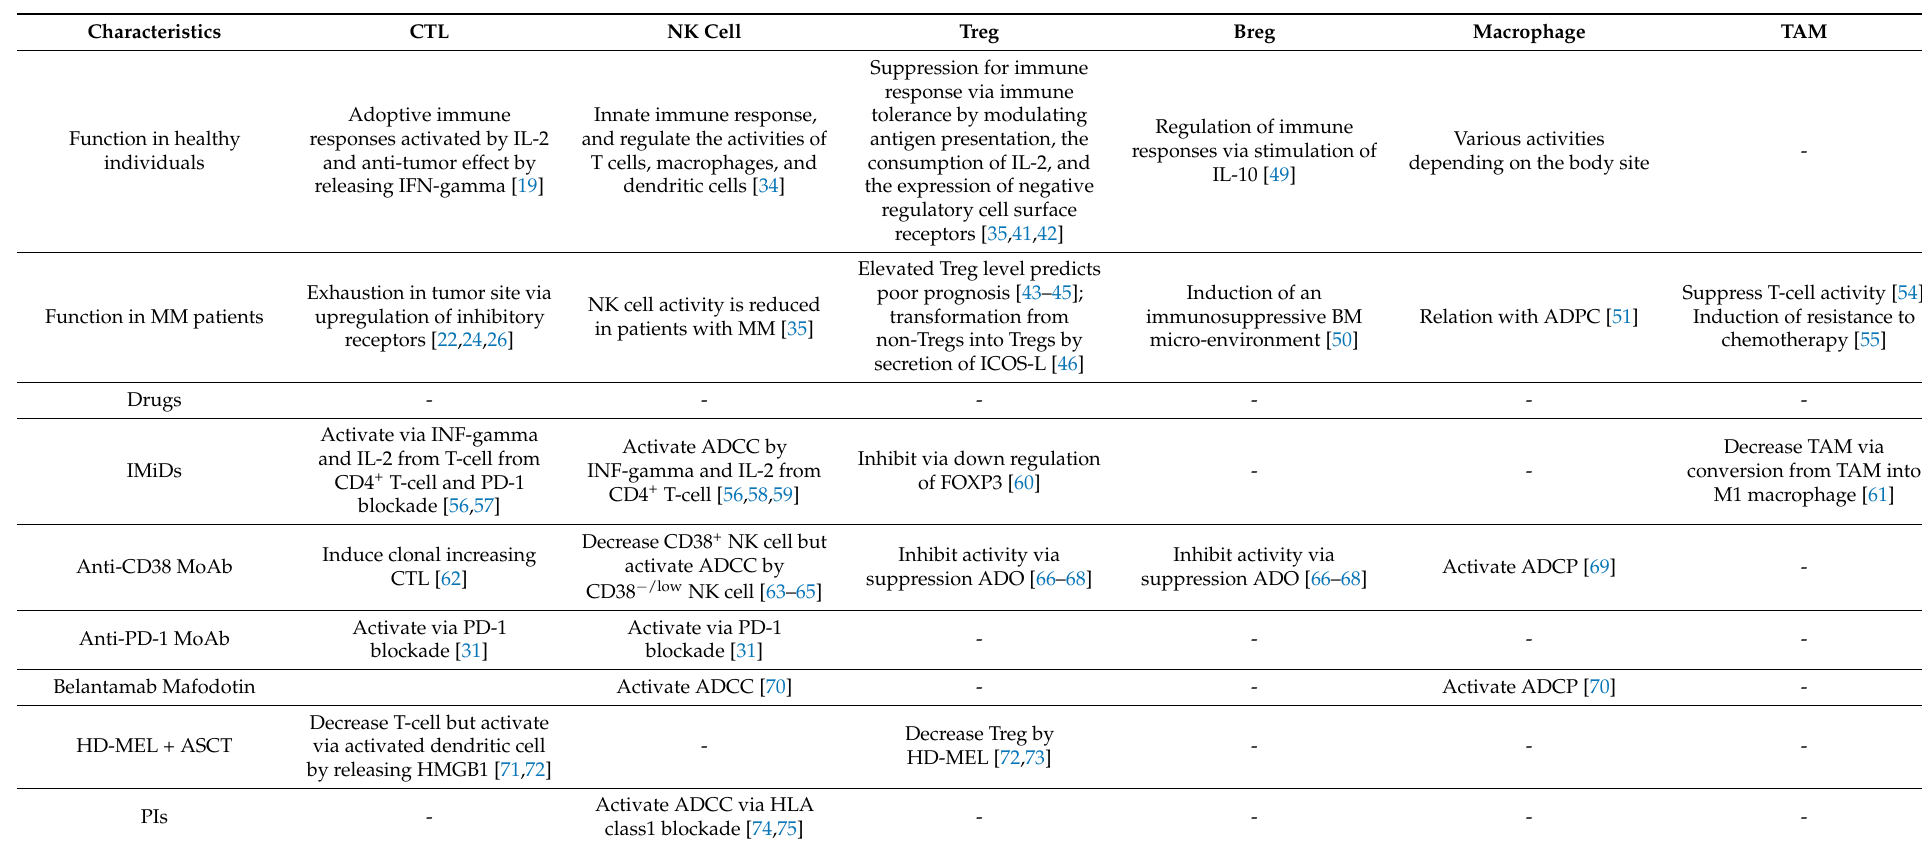
Table 1. Summary of function of immune cells and anti-myeloma agents for immune system. IMiDs, immunomodulatory drugs; MoAb, monoclonal antibody; PD-1, programed death-1; HD-MEL, high dose-melphalan; ASCT, autologous stem cell transplantation; PIs, proteasome inhibitor; CTL, cytotoxic T-cell; NK cell, natural killer cell; Treg, regulatory T-cell; Breg, regulatory B cell; TAM, tumor associated macrophage; MM, multiple myeloma; IL-2, interleukine-2; IFN-gamma, interferon gamma; ICOS-L, inducible T-cell co-stimulator ligand; ADCC, antibody-dependent cellular cytotoxicity; ADCP, antibody-dependent cellular phagocytosis; HMGB-1, high-mobility group box-1; FOXP3, forkhead box P3; and ADO, adenosine.